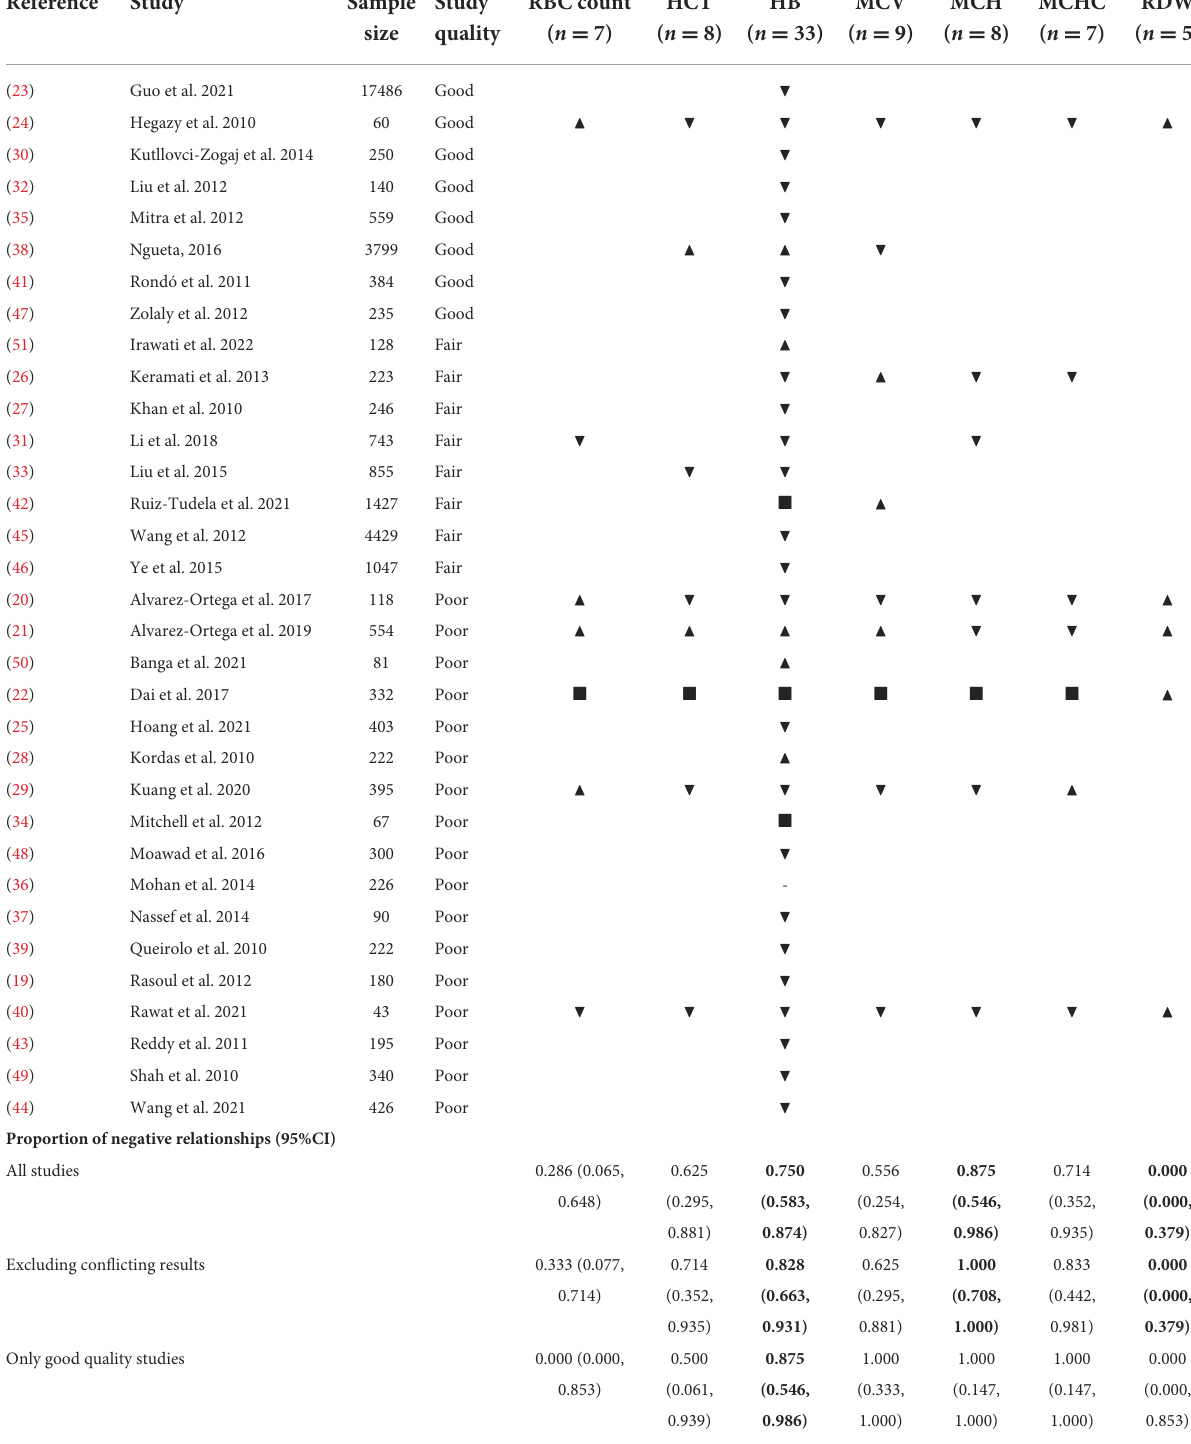
TABLE 1 Vote counting based on the direction of the relationship between lead concentration and red blood cell